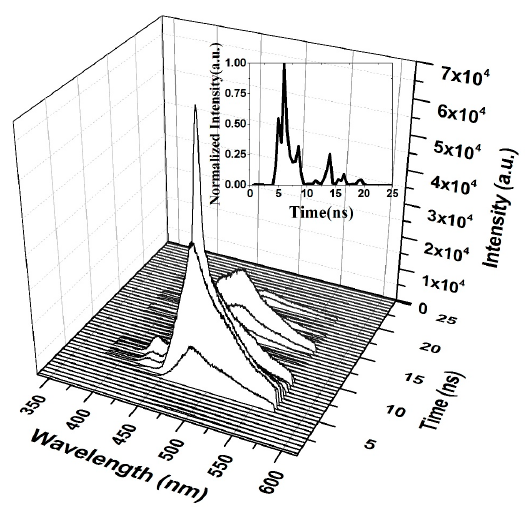
Figure 15. Time dynamics of the CO thin film at 15 mg/mL and at a high pump energy (5 mJ). The subfigure is the Z slice at 487 nm, which gives the intensity (a.u) vs time (ns) profile of the ASE peak at approximately 483 nm.